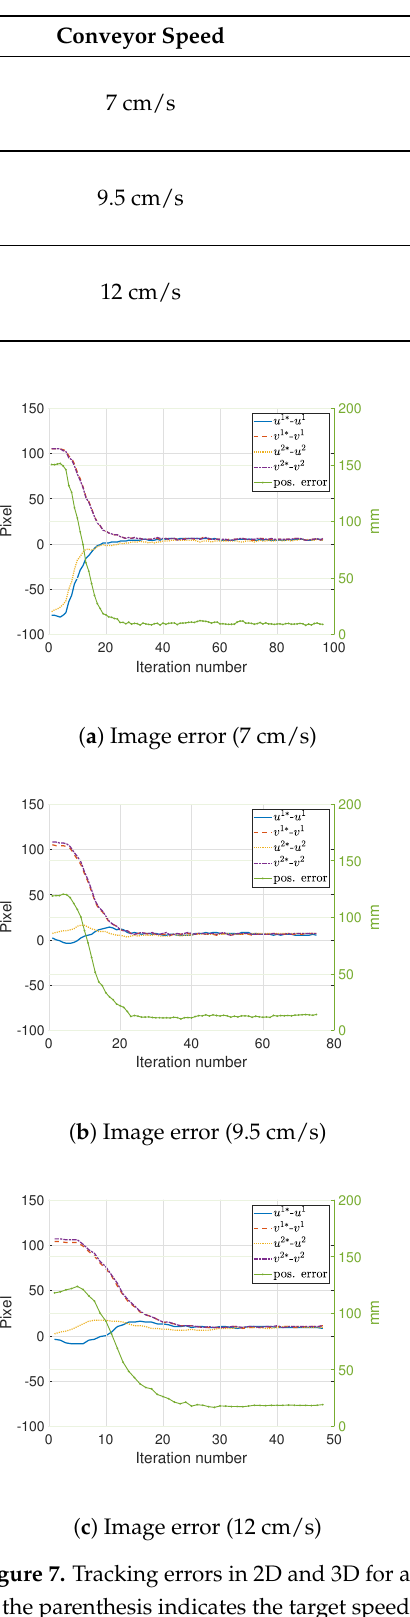
Table 2. Tracking error for a target with constant speed linear motion.